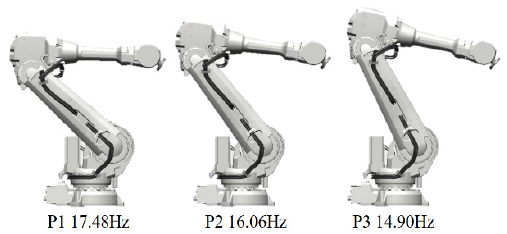
Figure 12. Chosen robot configurations for milling test.